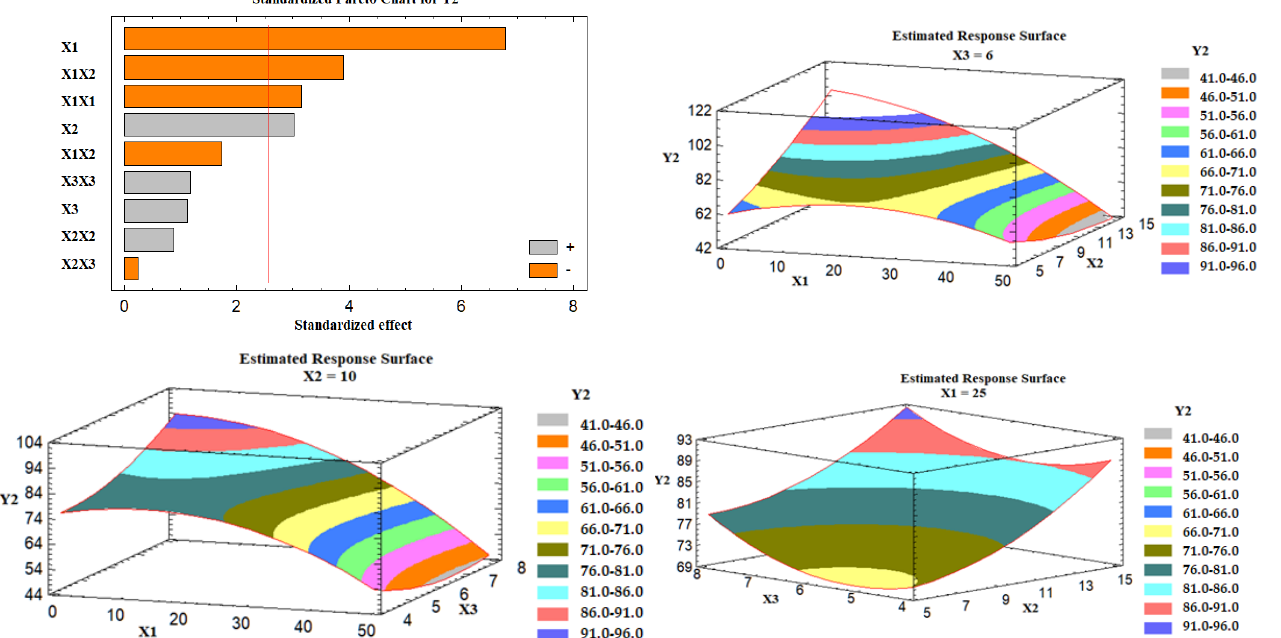
Figure 5. Pareto chart and estimated response surface plots for the effect of the studied factors on the tablet hardness (Y2). Notes: X1; the carrier mixture, X2; the excipient ratio; X3; the percentage of superdisintegrant.